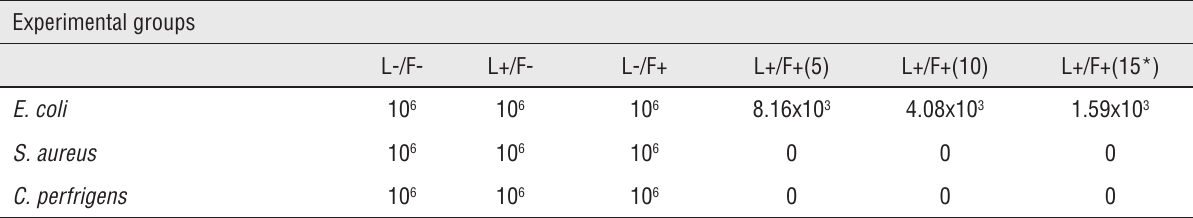
Table 1 - CFu log reduction of S. aureus and C. perfrigens and exponential reduction of E. coli . Experimental